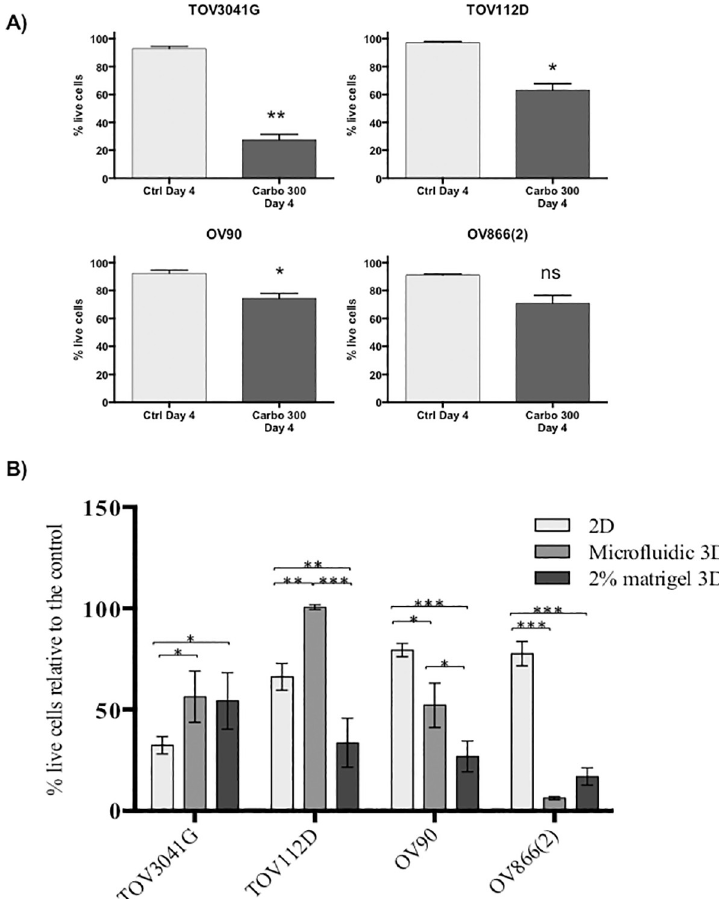
Fig 6. Comparison of carboplatin response between 2D-monolayers and two different 3D spheroid models. A) TOV3041G, TOV112D, OV90 and OV866(2) were culture as 2D monolayers for 4 days without treatment (Ctrl Day 4) or treated at day 2 with 300 μ M of carboplatin and assessed at day 4 (Carbo 300 Day 4). Bar graphs represent cell survival analysed by flow cytometry of control (light grey) and treated (dark grey). Data are shown as the mean ± SEM of three independent experiments � p < 0.05; �� p < 0.005; ns, non-significant (Student’s t-test) B) 2D-monolayer carboplatin sensitivity was compared to that of 3D spheroid cultures. Each treatment response was normalized relative to the percentage of live cells in comparison to the appropriate control. � p-value < 0.05; �� p-value < 0.005; ��� p-value < 0.0005; Turkey ANOVA multi comparison test of three independent